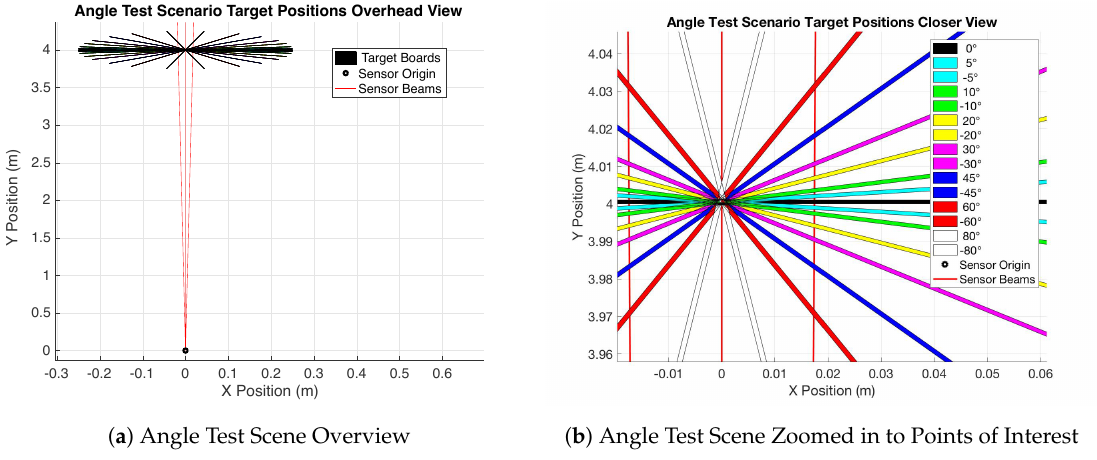
Figure 15. Illustration of the target angle test scene.